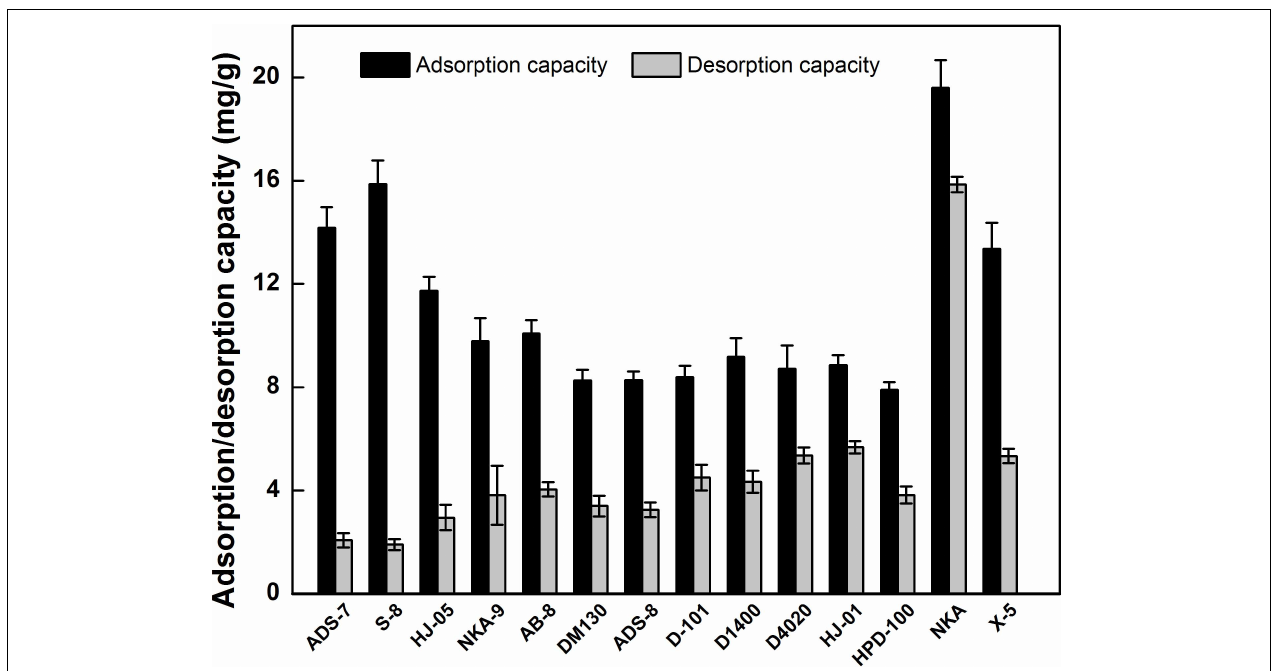
FIGURE 2 | Adsorption and desorption capacities of HSAF on different